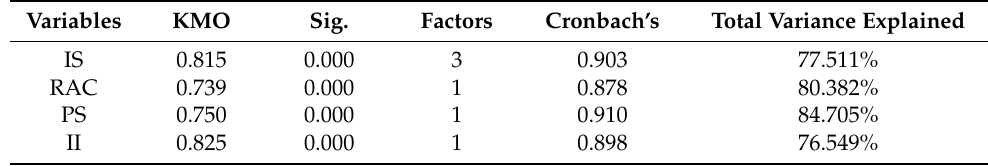
Table 3. Output of factor